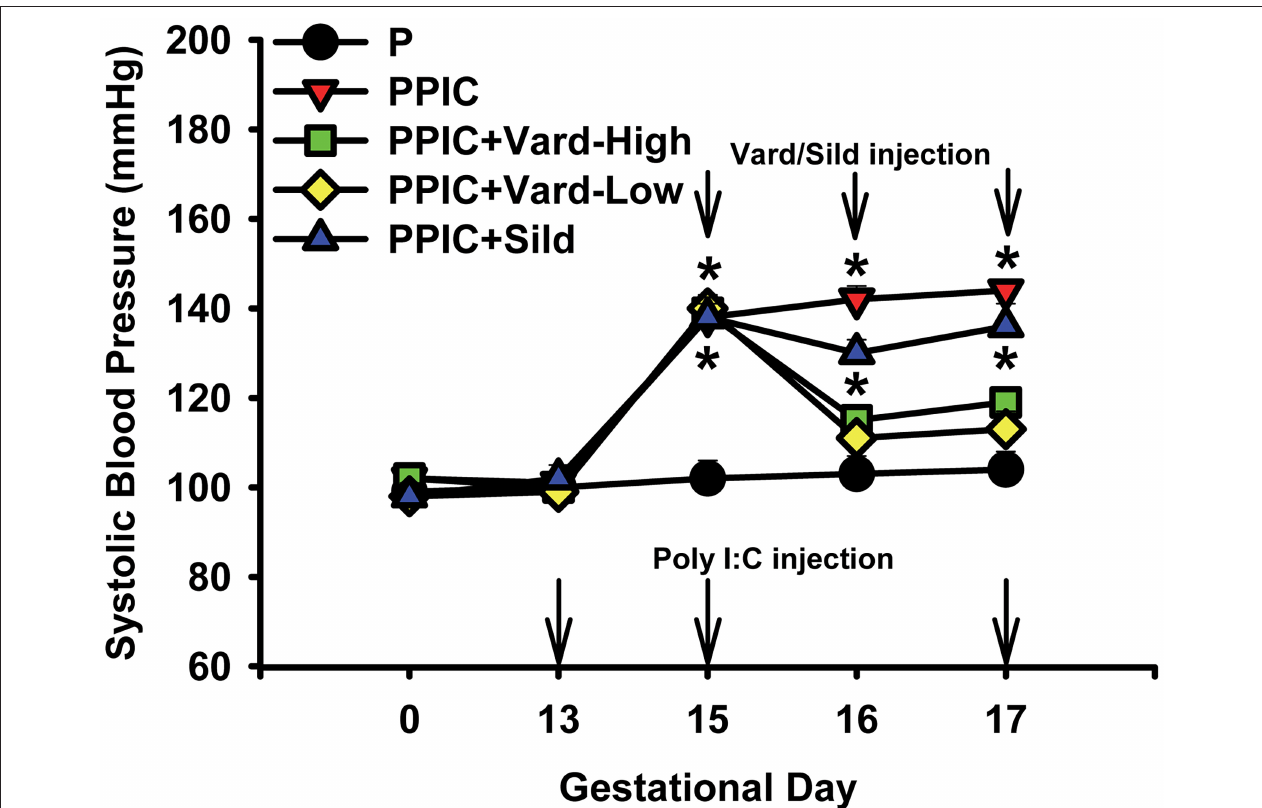
FIGURE 1 | Systemic blood pressures of control pregnant (P) mice ( n = 10), P mice treated with the TLR3 agonist and viral mimetic poly I:C (PPIC) ( n = 10), PPIC mice treated with a high dose ( n = 6) and low dose ( n = 6) of vardenafil (Vard), and PPIC mice treated with sildenafil (Sild) ( n = 6). * p < 0.05 by ANOVA compared to P mice.